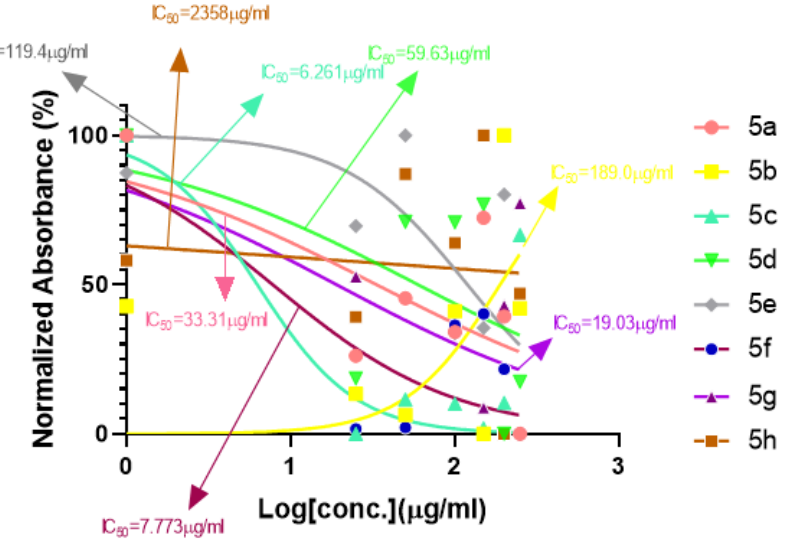
Figure 4. Antioxidant activities of compounds 5a – h with IC 50 (ascorbic acid as standard).